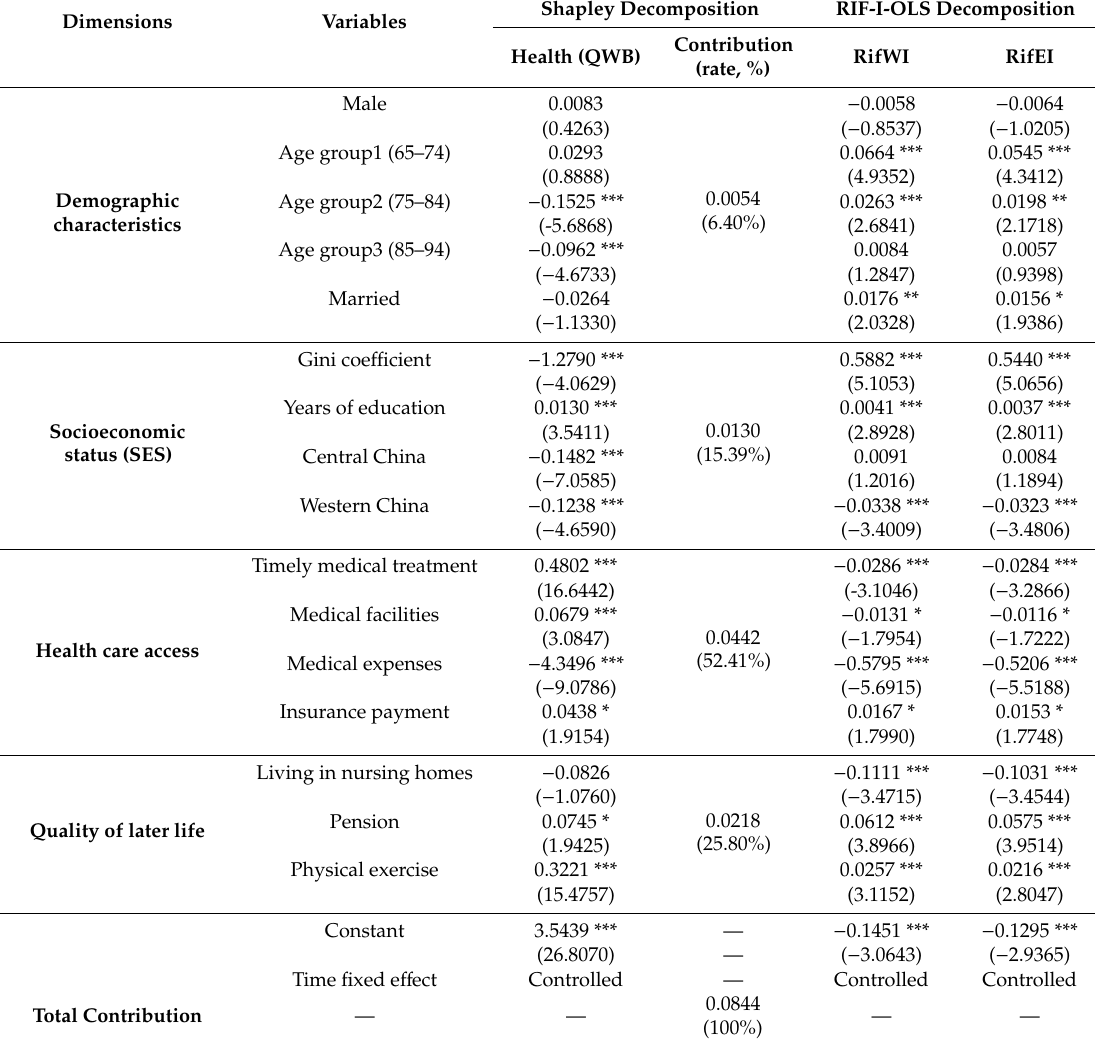
Table 6. Shapley decomposition and recentered influence function-index-ordinary least squares (RIF-I-OLS) decomposition of health inequality among the elderly in rural